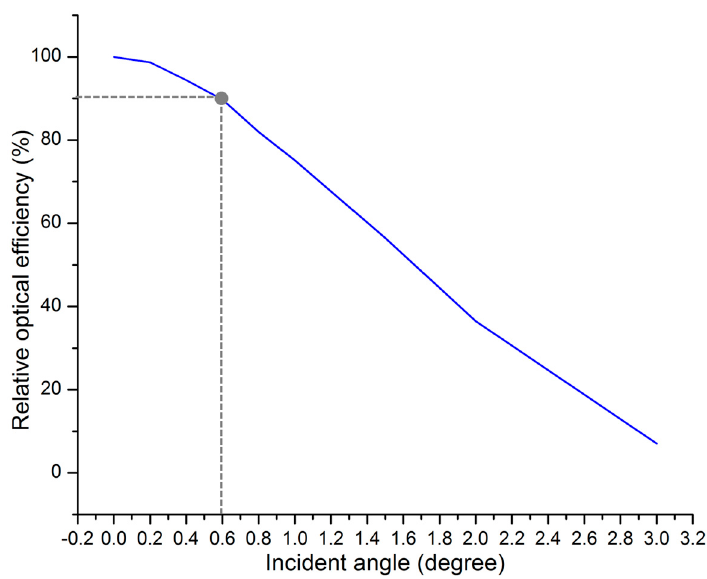
Figure 13. The tolerance of the designed collector.